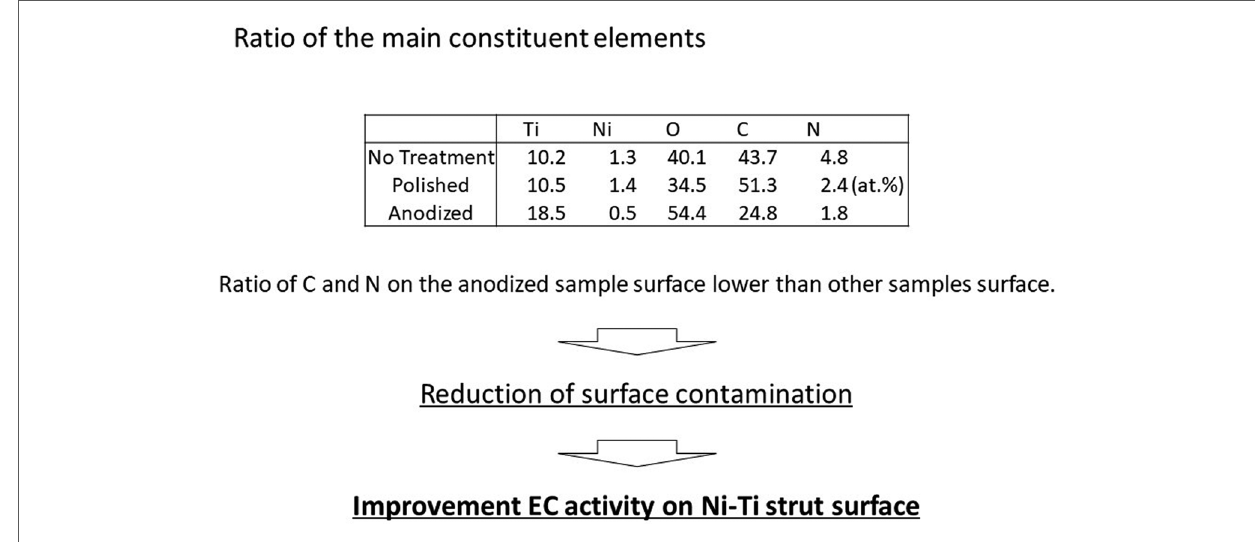
FIGURE 2 Atomic concentrations; the ratio of C and N on the anodized sample surface is lower than other samples